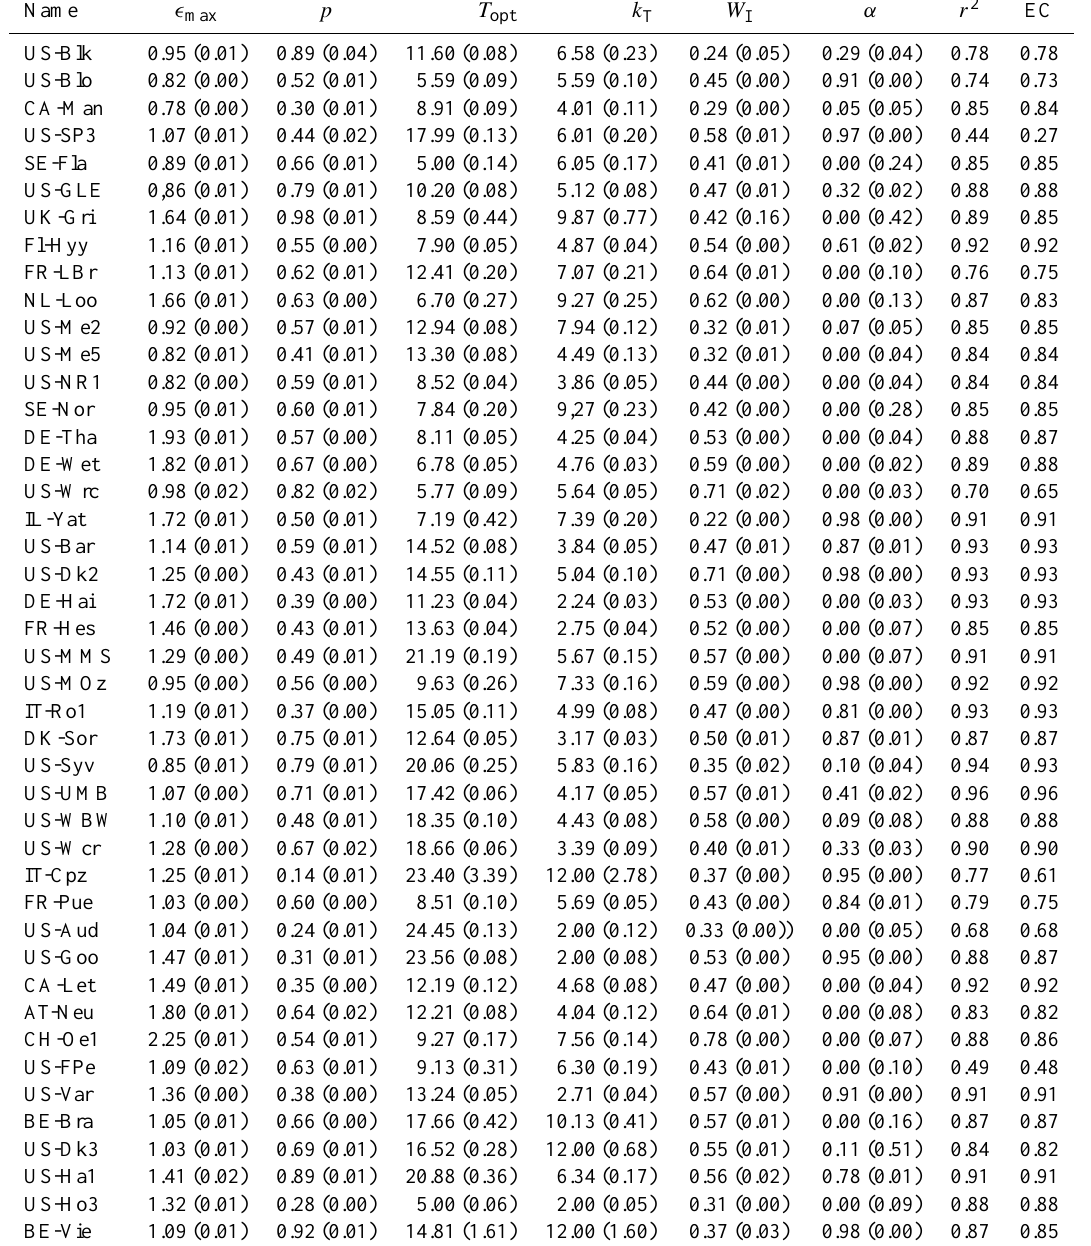
Table 2. Optimized constant model parameters with their 95% confidence intervals (in brackets) and model accuracy measures coefficient of determination r 2 and efficiency criterion EC with respect to the measured and modelled F G -time series. Full site names can be found